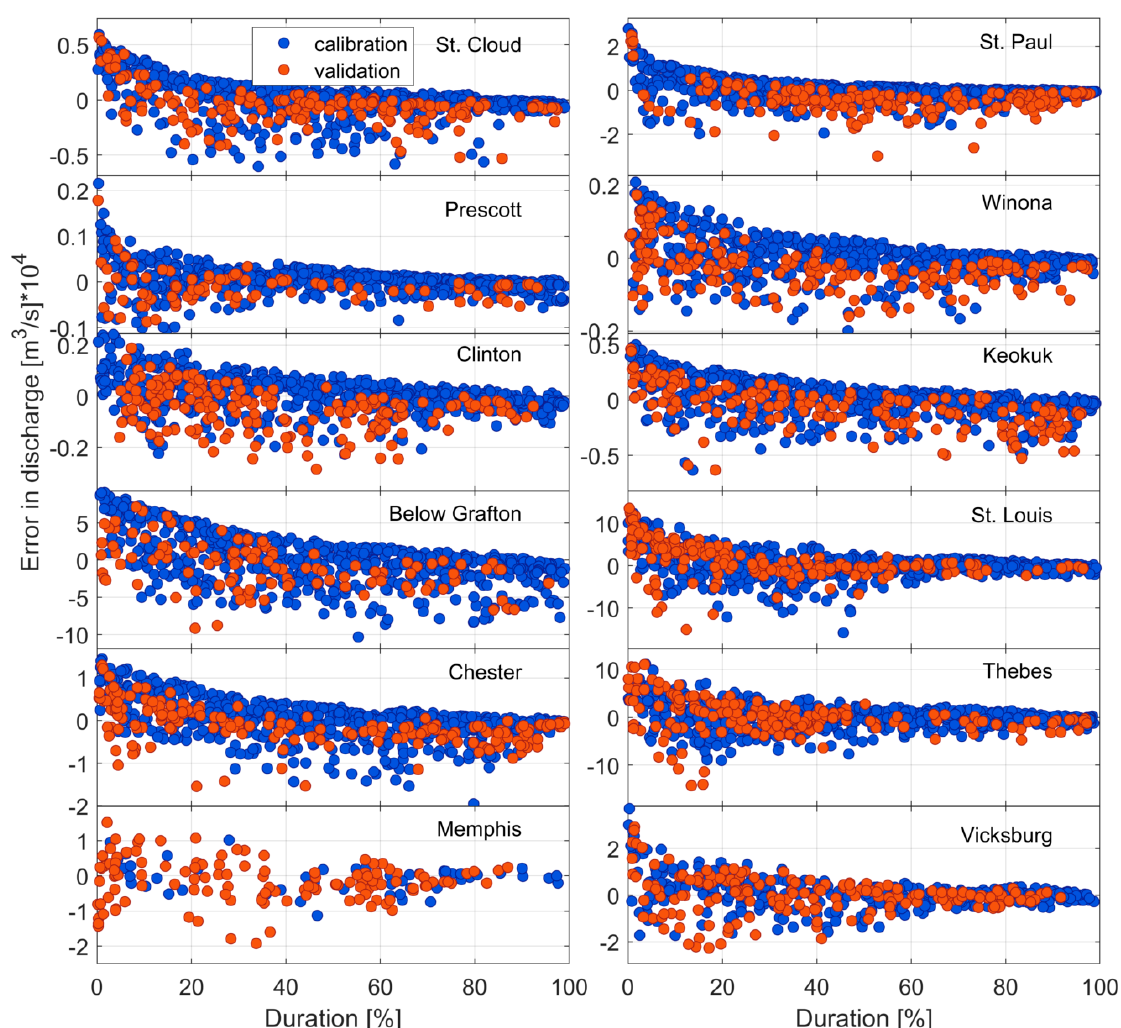
Figure 9. Errors between estimated and observed discharges in function of the duration.